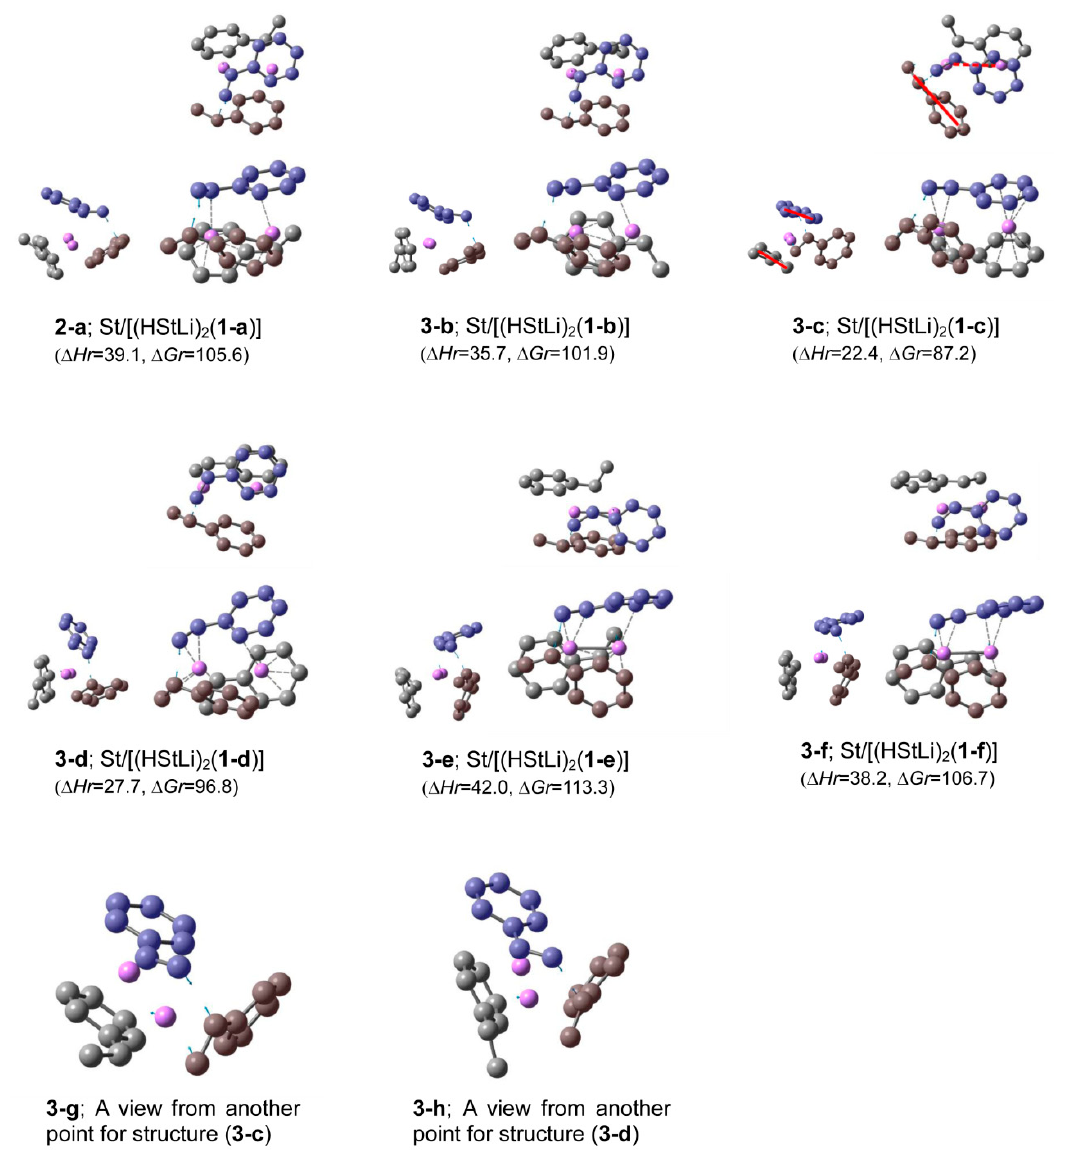
Figure 3. Optimized geometries and relative energies of transition states in the gas phase for the addition of styrene to each (HStLi) 2 shown in Figure 1. For each (HStLi) 2 , the transition state with the lowest ∆ G r , including 2-a shown in Figure 2, is shown ( 2-a and 3-b to 3-f ). Detailed arrangements of each structure are shown in the Arrangement column in Table 2 and also in the relevant description in the main text. 3-g and 3-h show a view from another point for 3-c and 3-d , respectively. The drawing details can be found in the description for Figure 2.